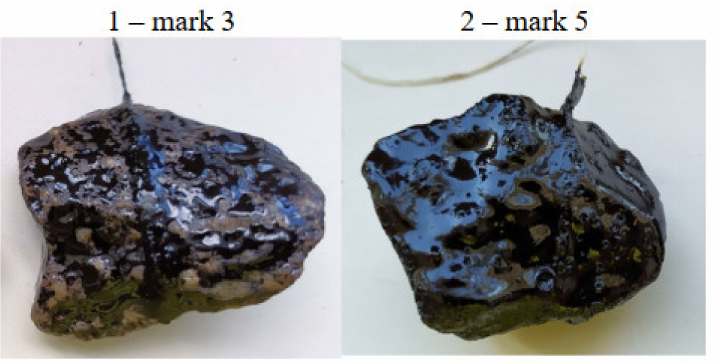
Figure 6. The gravel grains after testing two bitumen samples for adhesion to the gravel surface, 3 and 5 points,